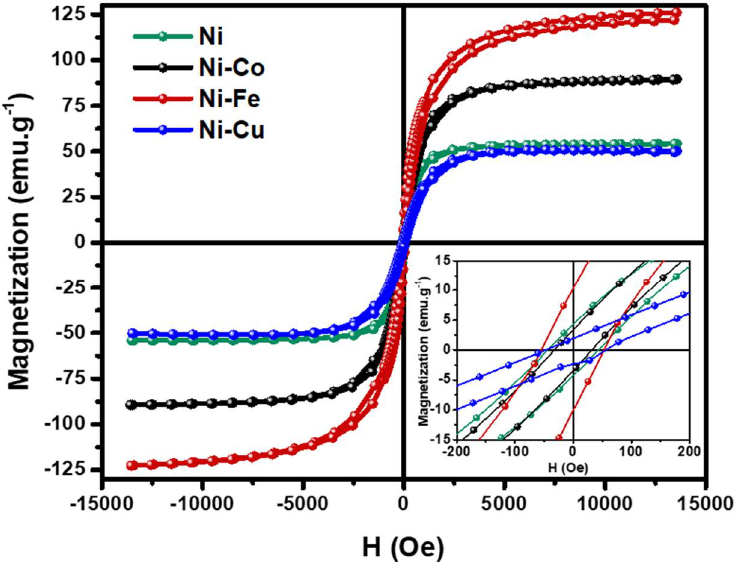
Figure 9. Magnetic hysteresis loops of the reduced samples ofNi, Ni-Co, Ni-Fe, and Ni-Cu. The insets show the low field detail of the magnetic hysteresis loops.